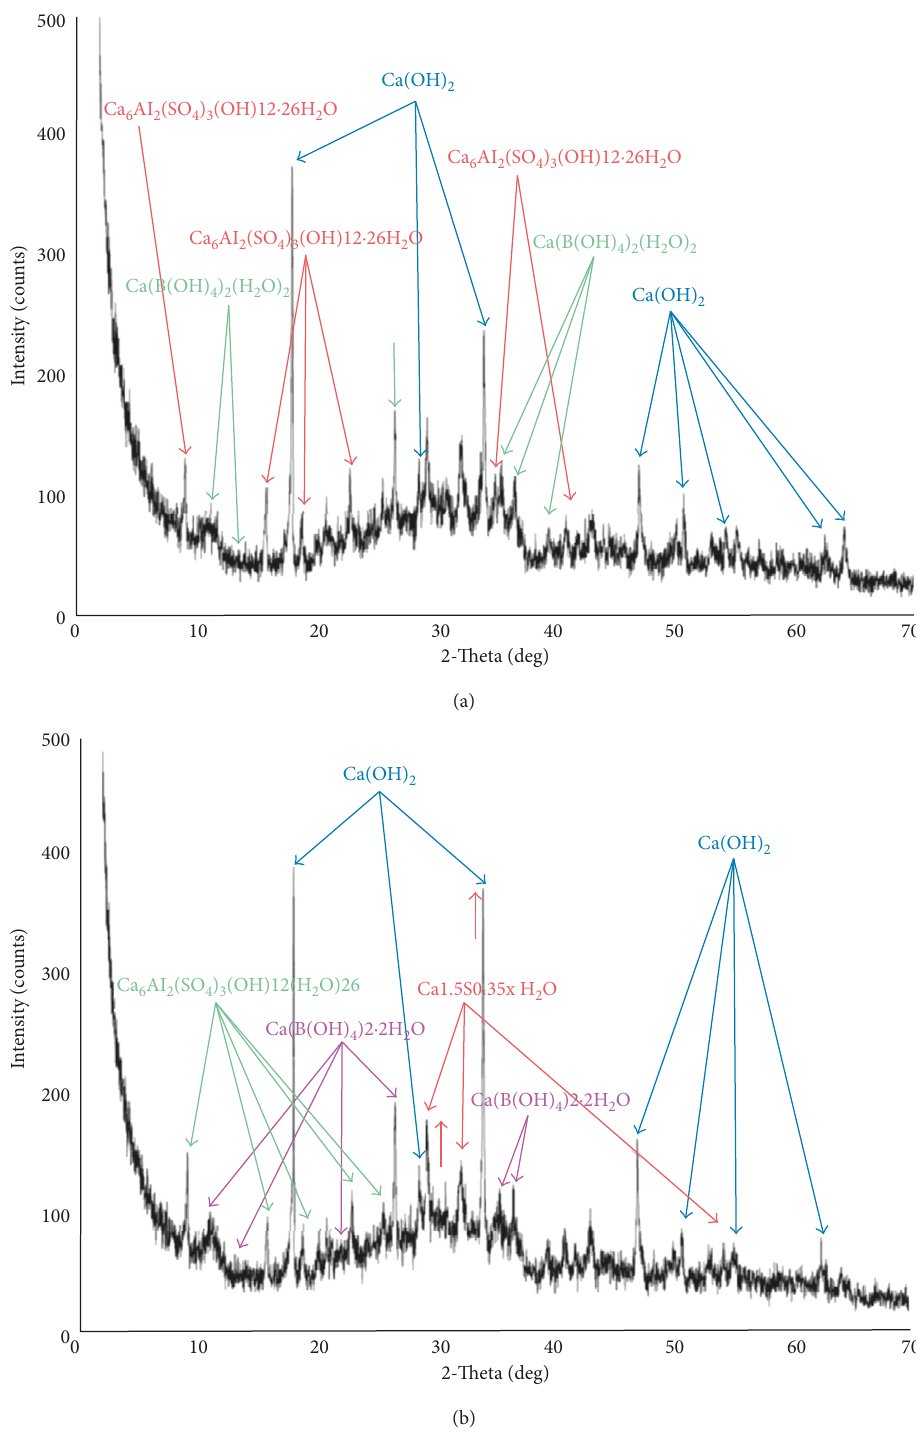
Figure 5: XRD results of (a) CTB without SS and (b) CTB that contains